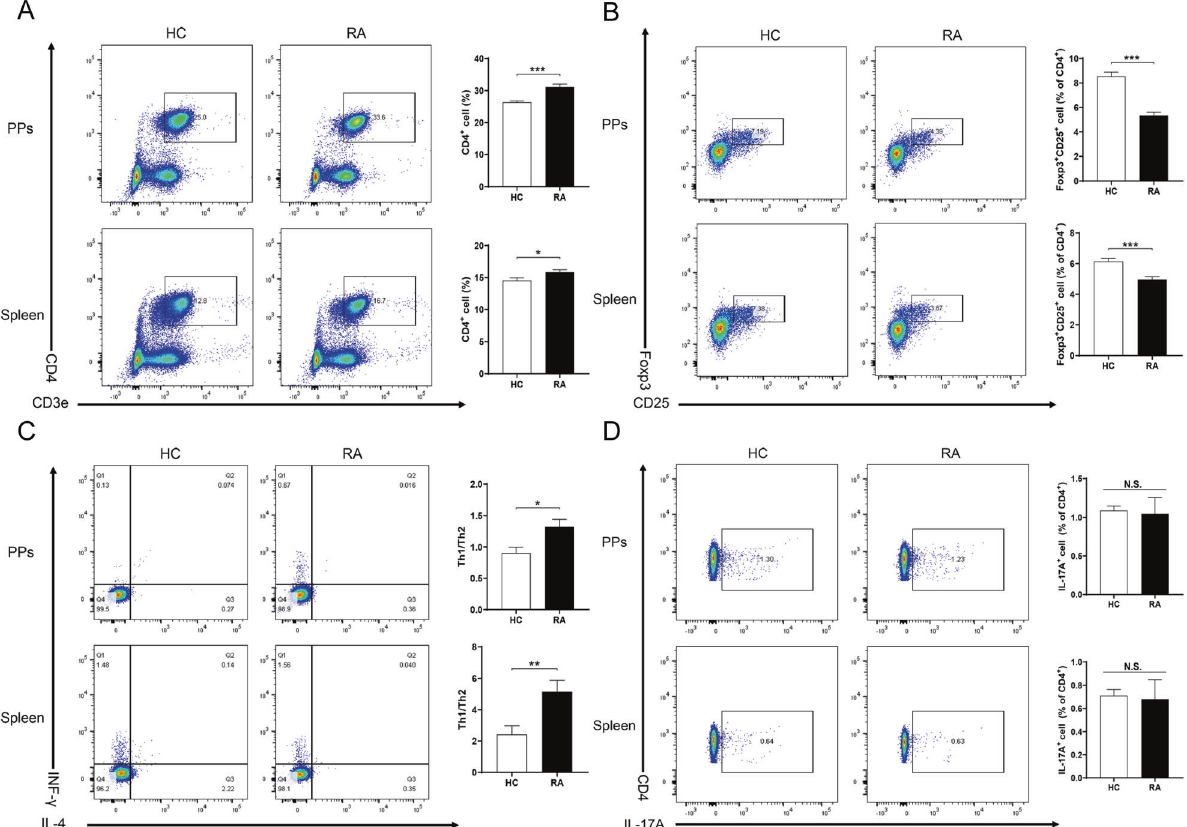
Fig. 4 FACS analysis of PPs and spleen samples between two groups after FMT from RA patients or healthy controls. A Representative images of different expression of CD4 + T cells (% of total cells) in PPs and spleen. PPs (Student t -test: t = − 4.944, P < 0.001); spleen (Student t -test: t = − 2.258, P = 0.036). B Representative images of different expression of Treg cells (Foxp3 + CD25 + , % of CD4 + T cell) in PPs and spleen. PPs (Student t -test: t = 7.443, P < 0.001); spleen (Student t -test: t = 4.290, P < 0.001). C Representative images of different expression of Th1 cells (IFN- γ + , % of CD4 + T cell) / Th2 cells (IL-4 + , % of CD4 + T cell) in PPs and spleen. PPs (Student t -test: t = − 2.860, P = 0.010); spleen (Student t -test: t = − 2.955, P = 0.008). D Representative images of different expression of Th17 cells (IL-17A + , % of CD4 + T cell). PPs (Student t -test: t = − 0.042, P = 0.967); spleen (Student t -test: t = 0.426, P =